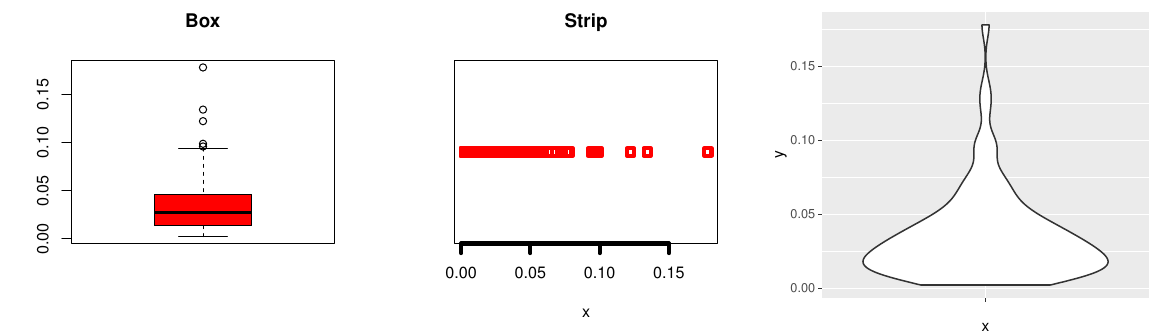
Figure 5. Data description for the COVID-19 data using box, strip, and violin plots.